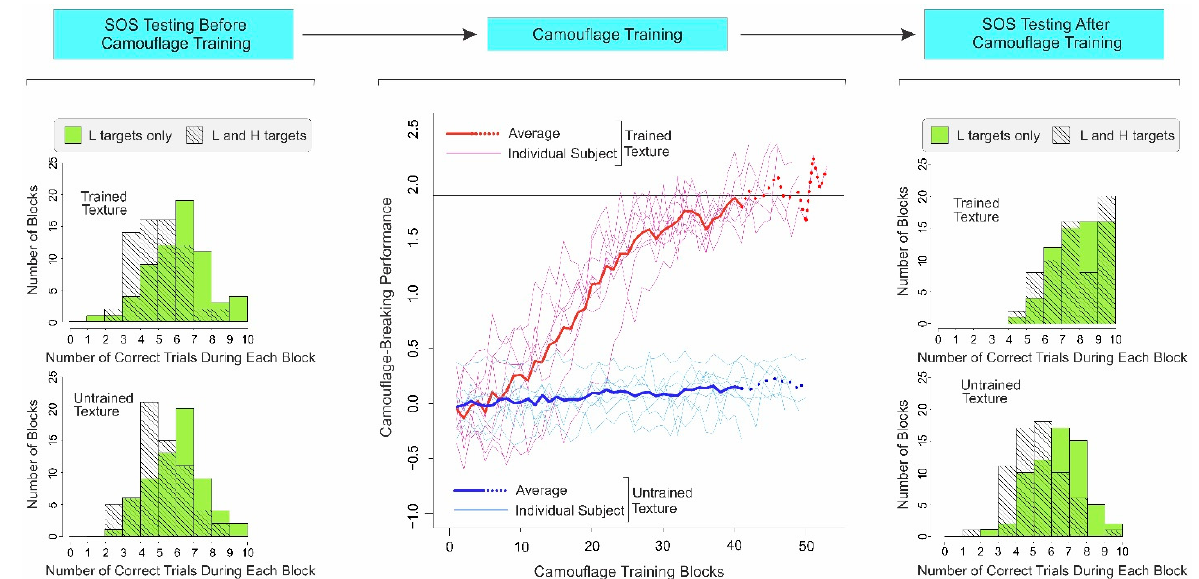
Figure 3. Results of Experiment 2. The results are plotted using the same conventions as in Figure 2. The only difference is that in this experiment, subjects were also trained in a second, nominally untrained texture using random feedback ( thin aqua lines and thick blue line , middle panel ). See text, for additional details.